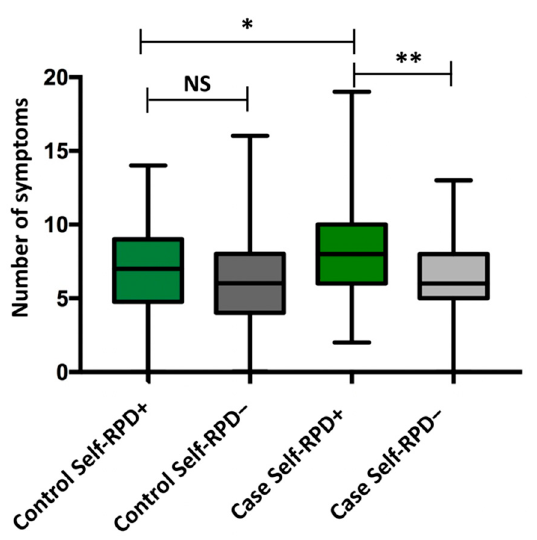
Figure 2. Self-RPD and the number of symptoms between groups. Control self-RPD positive (+): median = 7.0, Q 1 = 4.7, Q 3 = 9.0, minimum = 0.0, maximum = 14.0; Control self-RPD negative ( − ): median = 6.0, Q 1 = 4.0, Q 3 = 8.0, minimum = 0.0, maximum = 16.0; Case self-RPD positive (+): median = 8.0, Q 1 = 6.0, Q 3 = 10.0, minimum = 2.0, maximum = 19.0; Case self-RPD negative ( − ): median= 6.0, Q 1 = 5.0, Q 3 = 7.0, minimum = 0.0, maximum = 13.0. Statistics: Mann–Whitney U. Abbreviations and symbols: Self-RPD: Self-reported periodontitis disease, NS: Not